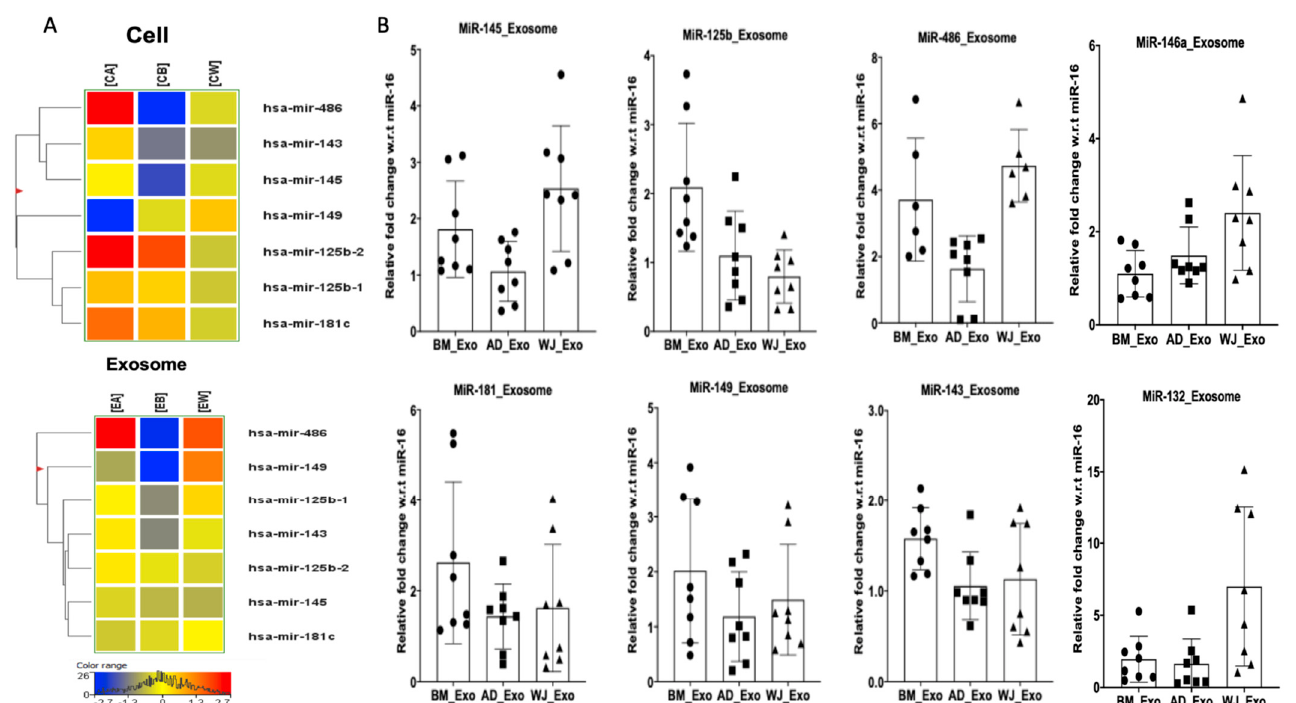
Figure 3. Expression patterns of miRNAs in hMSCs and exosomes. ( A ) Heatmap showing seven common miRNAs in hMSCs and exosomes. CB = Cells’ Bone marrow, CA = Cells’ Adipose tissue, CW = Cells’ Wharton Jelly; EA = Exosomes’ Adipose tissue, EB = Exosomes’ Bone marrow, EW = Exosomes’ Wharton Jelly. ( B ) Validations of the miRNAs in exosomes of three different sources. The miRNAs were isolated from exosomes and validated through qRT ‐ PCR.